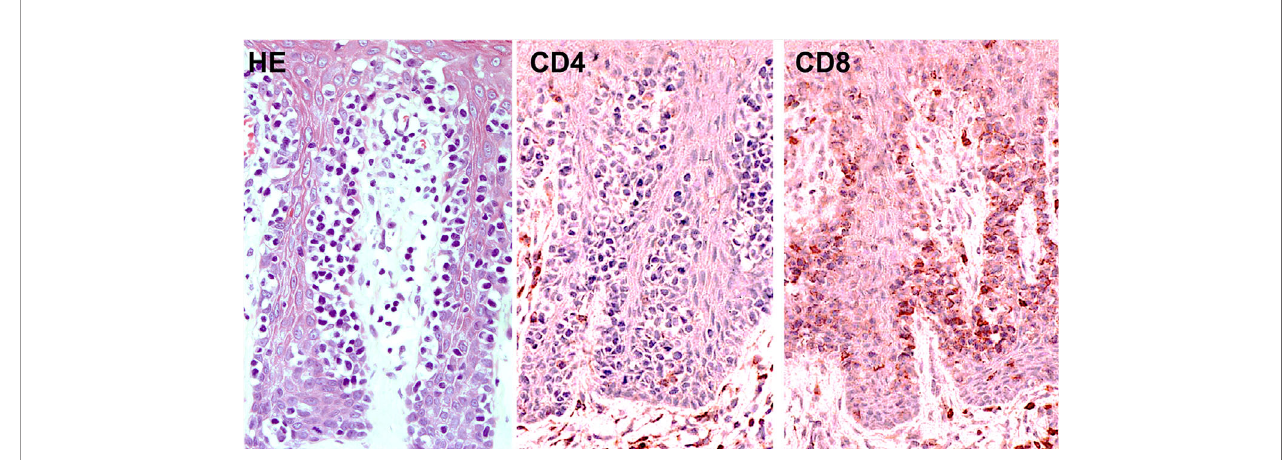
FIGURE 8 | Histopathology (left; hematoxylin and eosin, HE) and immunostaining for CD4 (middle) and CD8 (right) in CD8 + pagetoid